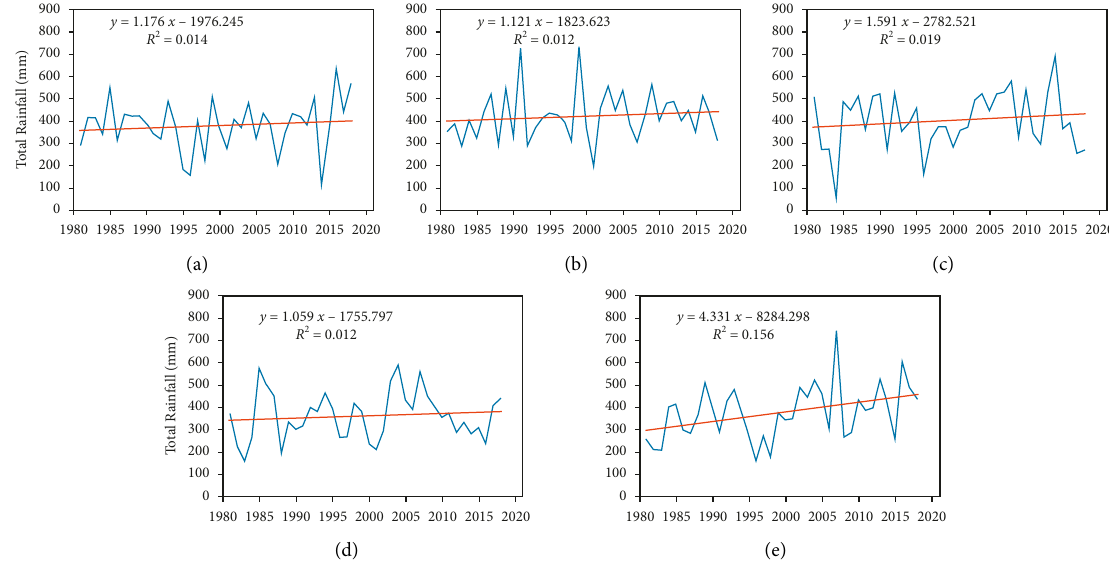
Figure 5: Linear plots of minor seasonal total rainfall amount over the Middle Sector (a and e) and Transition Zone (b-d). (a) Koforidua, (b) Kete Krachi, (c) Wenchi, (d) Sunyani, and (e) Kumasi. Data Used: in situ rainfall data from the Ghana Meteorological Agency.